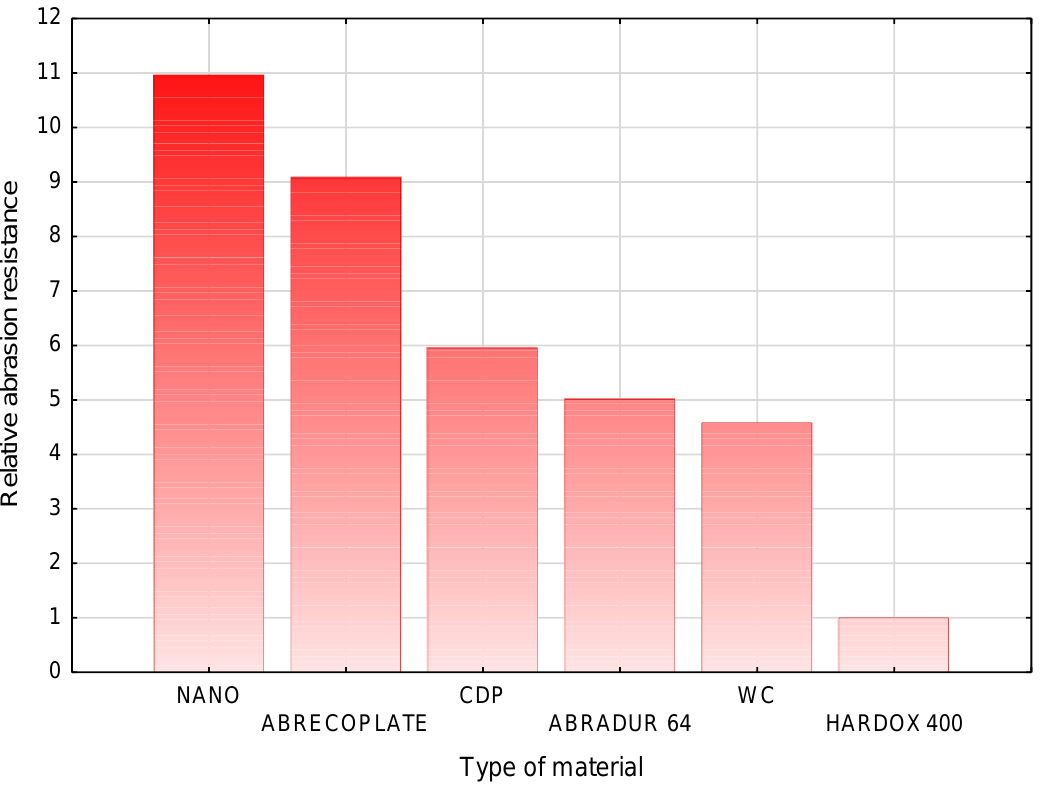
Figure 6. Comparison of the results of relative abrasive wear resistance of selected construction materials.